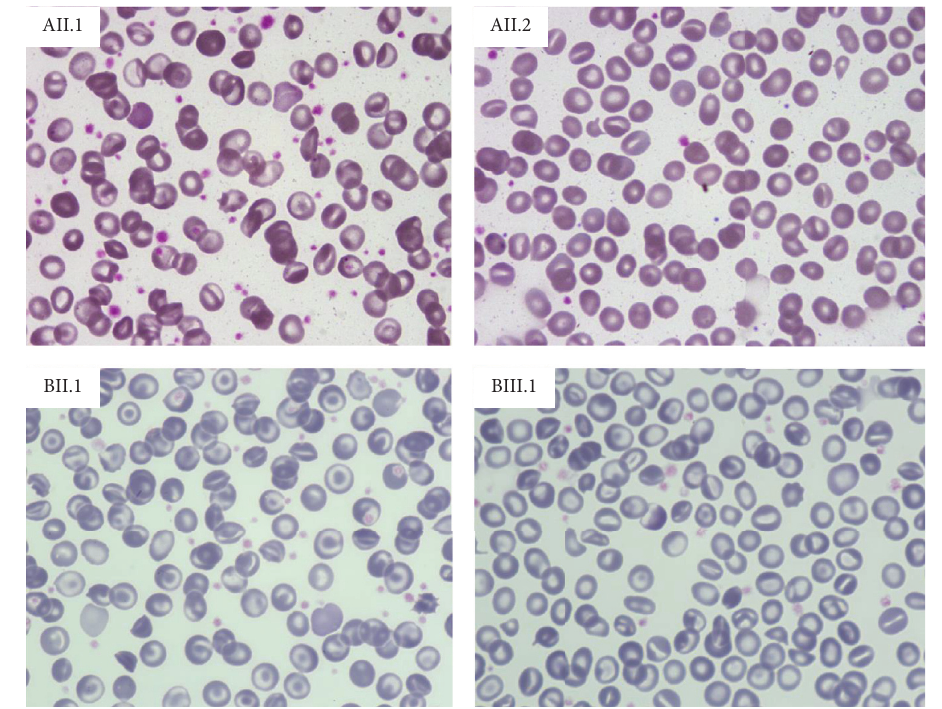
Figure 2: Light microscopy of peripheral blood, 63x.